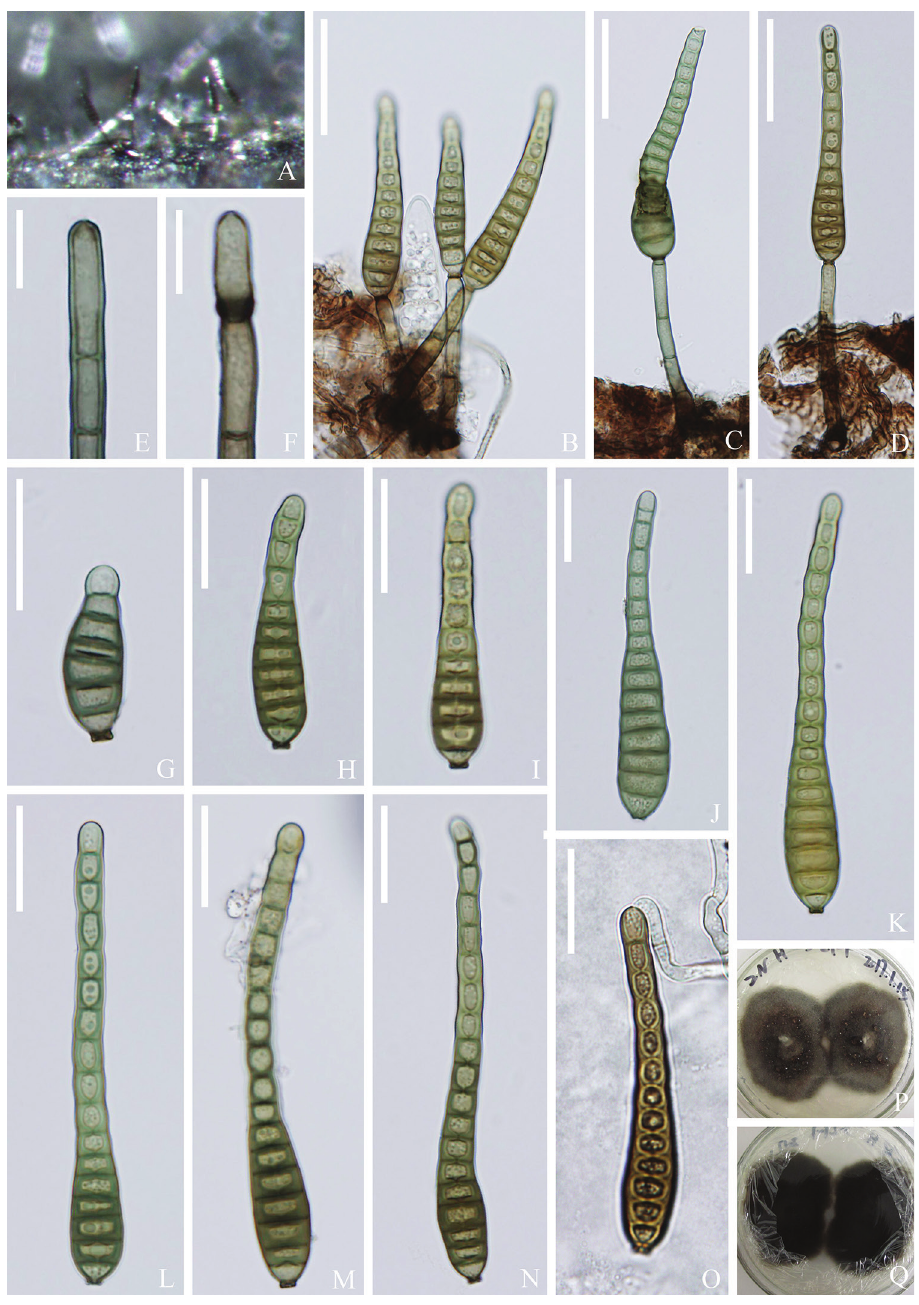
Figure 5. Distoseptispora thysanolaenae (KUN-HKAS 112710) A colonies on the substratum B-D con- idiophores with conidia E, F conidiogenous cells G-N conidia O germinating conidium P, Q culture on PDA Scale bars: 30 μm ( B-D ); 10 μm ( E, F ); 20 μm ( G-O